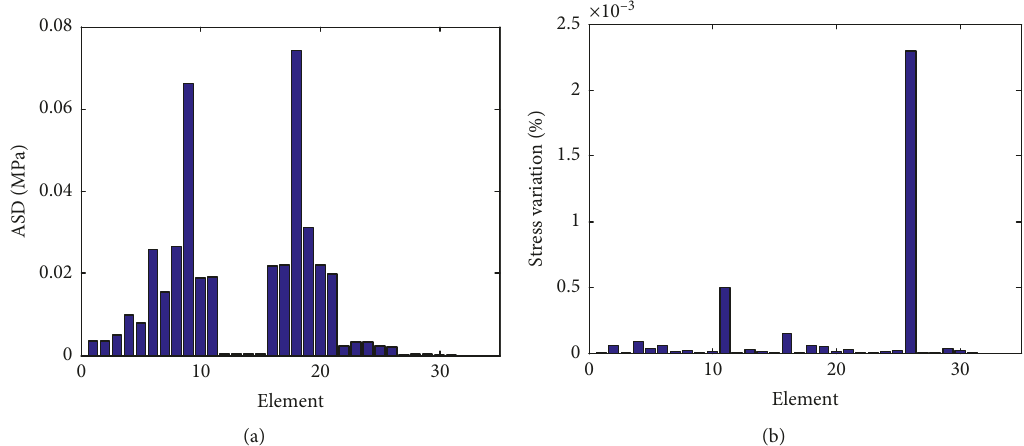
Figure 12: Multiple damages at elements 9 and 18 using noise-free displacements and local-based approach of (a) ASD and (b) stress variation